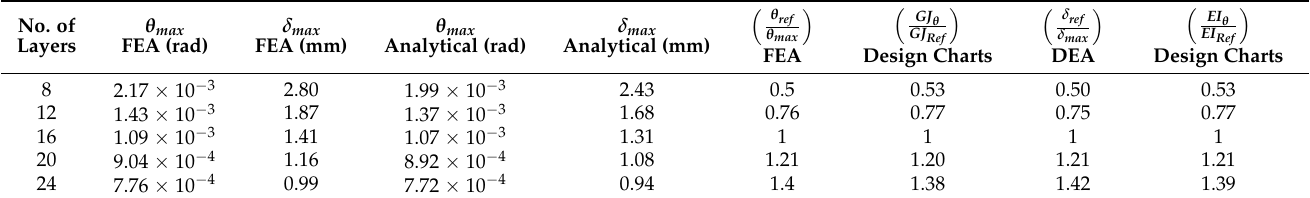
Table 1. Bending and torsional results obtained using analytical and FEA approaches (FD = 0 ◦ ). θ max No. of FEA (rad) Layers